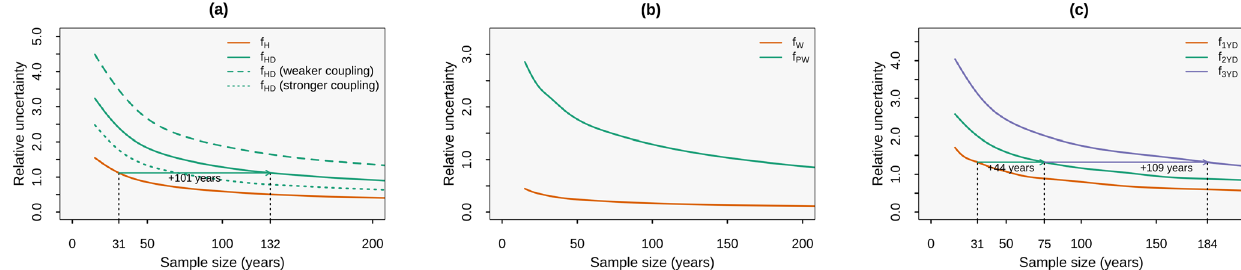
Fig.2|Dependenceoftheuncertaintyduetointernalclimatevariabilityonthe sample size. a Relative uncertainty due to internal climate variability in the fre- quency of univariate hot events f H (orange) and compound hot-dry events f HD (solidgreen).Dashedanddottedgreenlinesshowtherelativeuncertaintyin f HD for grid points with the 35% strongest and weakest coupling, respectively (see Meth- ods).Relative uncertainty is de fi ned as the ratio oftwice the standarddeviationto the mean of the frequency f across ensemble members averaged over global